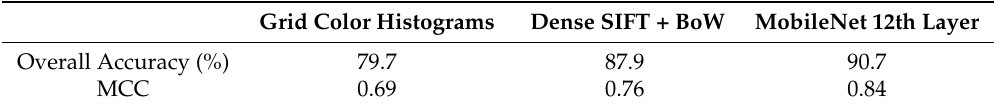
Table 5. Overall accuracy and Matthews Correlation Coefficient (MCC) performance indicators on three selected experiments (white